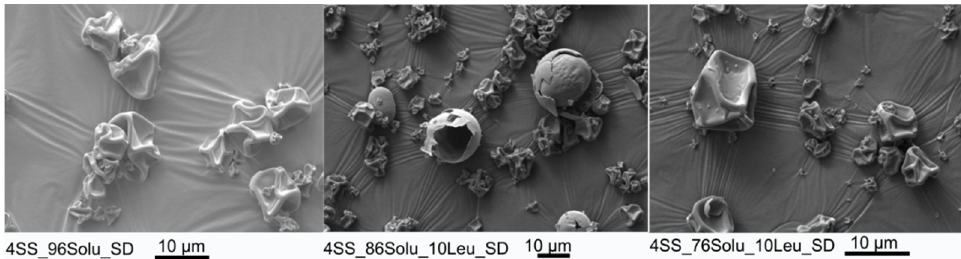
Figure 5. Representative SEM images of the spray-dried formulations (4% salbutamol/96% soluplus (4SS_96Solu_SD), 4% salbutamol/86% soluplus/10% leucine (4SS_86Solu_10Leu_SD), and 4% sal- butamol/76% soluplus/20% leucine (4SS_76Solu_20Leu_SD)). tamol/76% soluplus/20% leucine